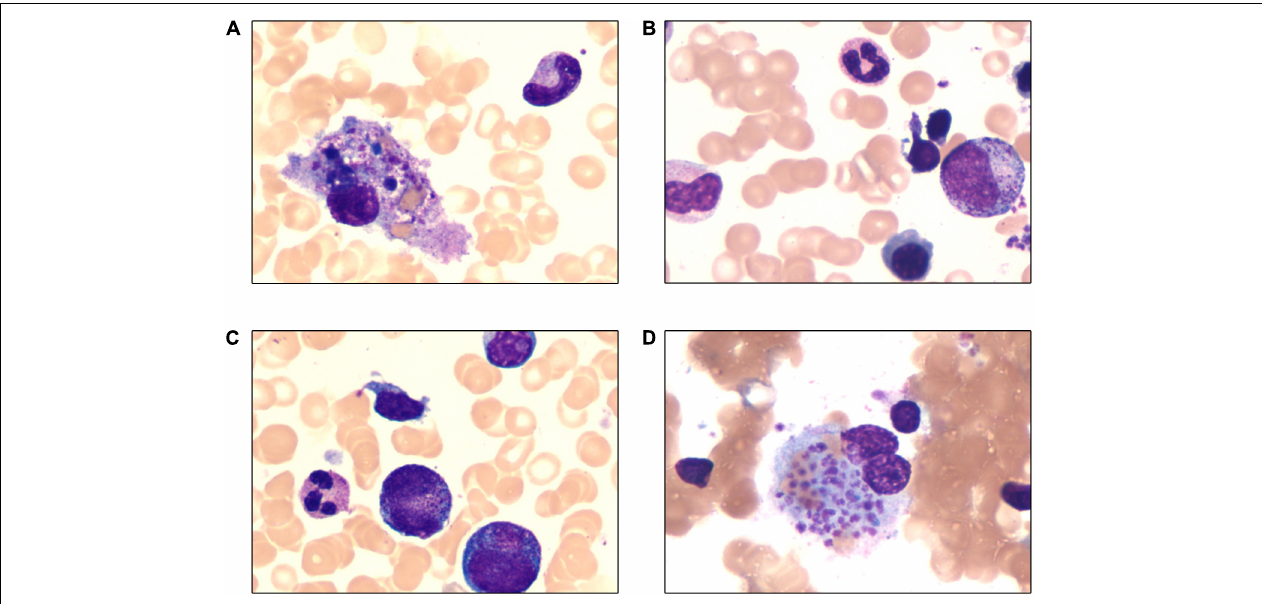
FIGURE 1 | Wright-Giemsa stain of bone marrow ( × 1,000). (A) Hemophagocytosis in bone marrow smear. (B–D) Large granular variant lymphocytes in bone marrow smear and the proportion was 6%.